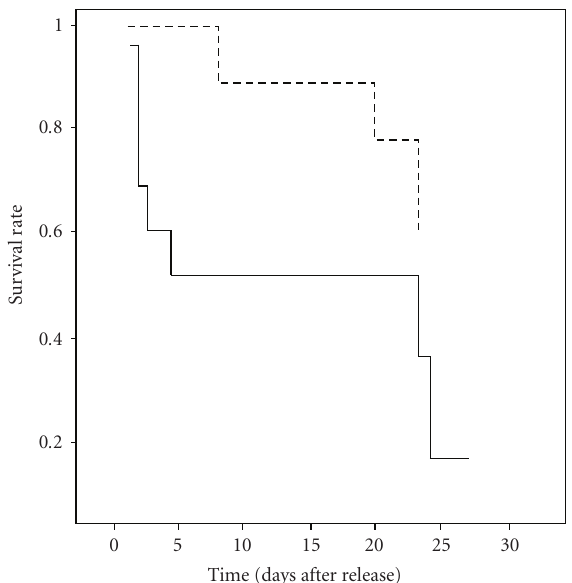
Figure 1: The proportion of voles surviving against the cumulative time from release of radio-collared animals on mink (solid line) and mink free (dashed line) islands.